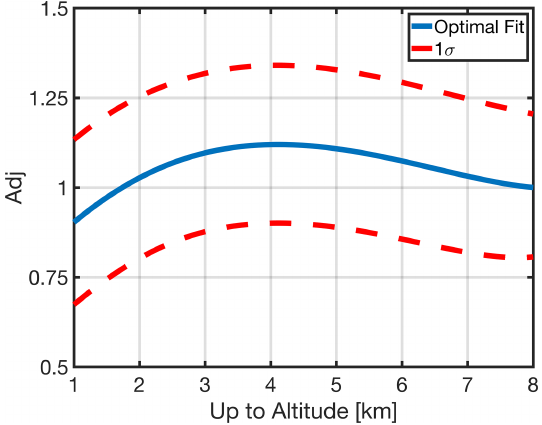
Figure 6. The adjustment factor is the ratio of the centroid of the polygon-bounding 25th and 75th percentiles of the observed HCHO / NO 2 columns by NASA’s aircraft between the surface and 8km to the ones between the surface and the desired altitude. This factor can be easily applied to the observed HCHO / NO 2 columns to translate the value to the desired altitude stretching down to the surface (i.e., PBLH). The optimal curve follows a quadratic function formulated in Eq.